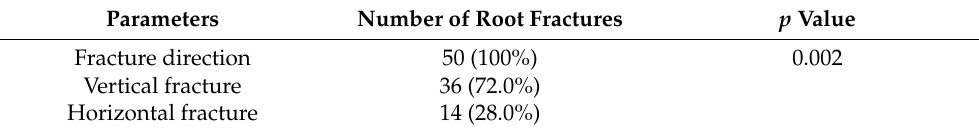
Table 1. Fracture direction of 50 root fractures in endodontically treated teeth.